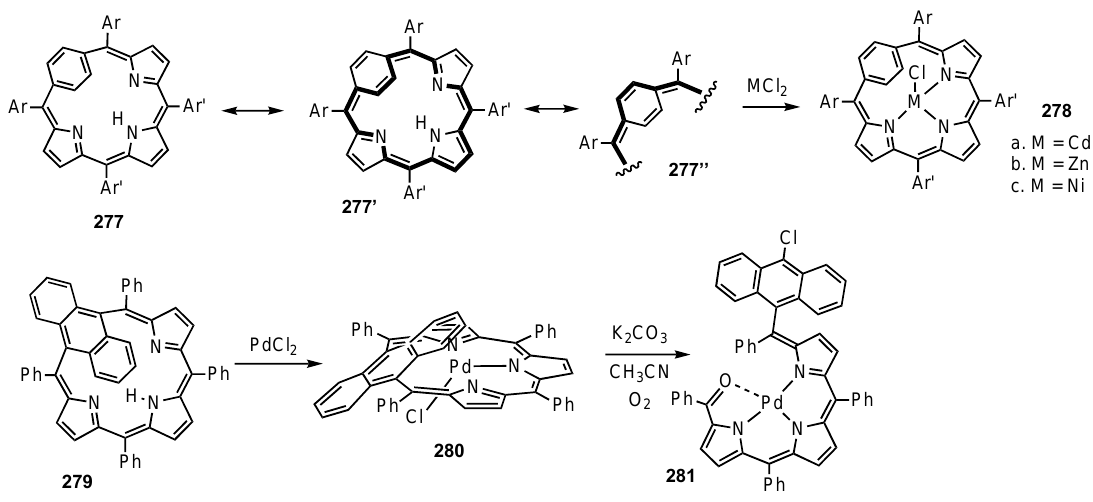
Scheme 44. Synthesis of rhodium(III) carbaporphyrins from tetraphenylbenziporphyrin.